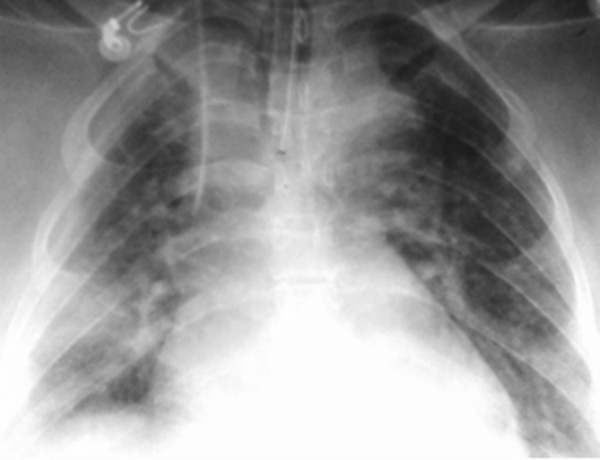
Chest radiography upon arrival displayed signs of pneumonia, for example, in the right lower lobe.